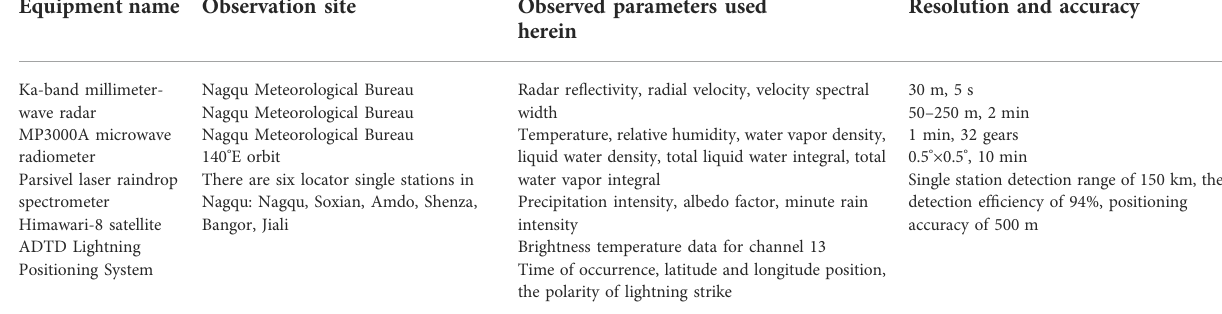
TABLE 1 Basic information about observation